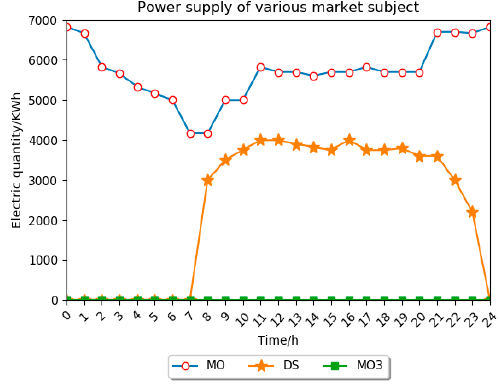
Figure 9. Electricity supply of various market subjects.